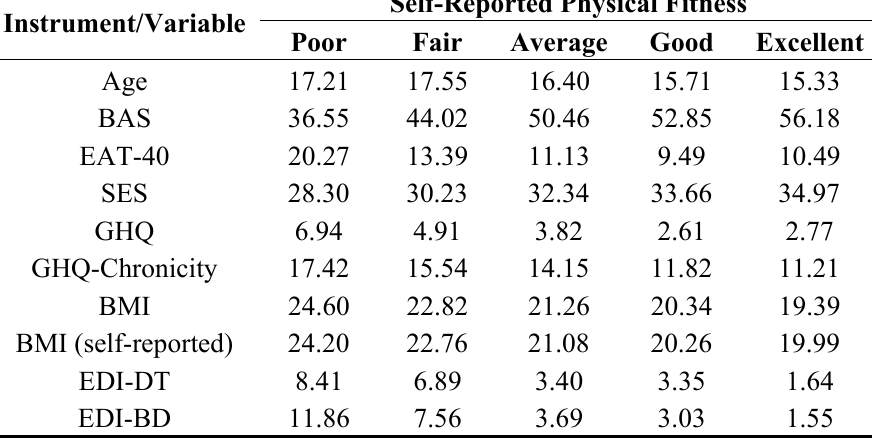
Table 4. Self-reported physical fitness and scores on the different variables included in the study.